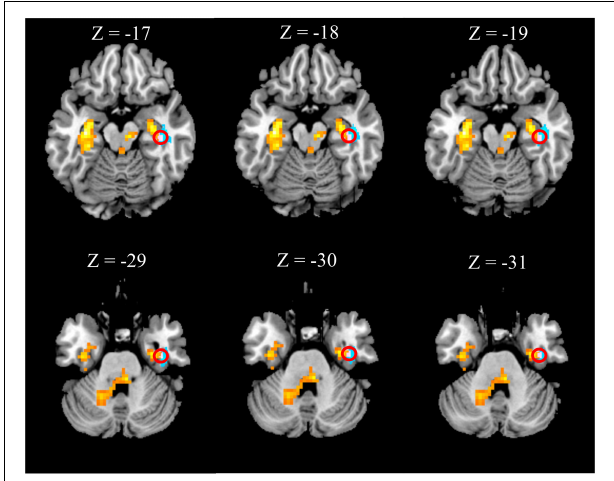
FIGURE 3 | Overlapped brain region with structural and functional changes. The right hippocampus (first row) and right fusiform gyrus (second row) within the red circle represent the overlapped areas with both increased zALFF (hot colored regions) and decreased GMV (cold colored regions) in patients with CTN. GMV, gray matter volume; ALFF, amplitude of low-frequency fluctuation; CTN, classic trigeminal